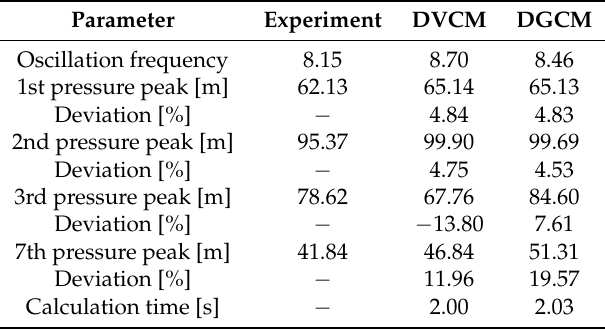
Figure 9. Comparison of the experimental data of experiment 5 [43] with the simulated results obtained with DVCM and DGCM. Table 6. Comparison of DVCM, DGCM, and experimental results for experiment 5